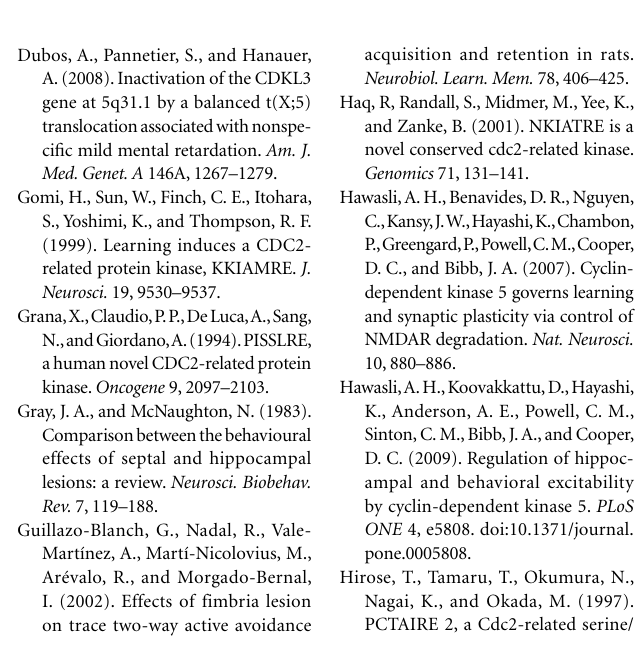
no signifi cant interaction between genotype and day ( F P = 0.9680). (B) AR latency by trial days. Unpaired Student’s t- test revealed no signifi cant differences between Cdkl2 + / + and Cdkl2 LacZ/LacZ mice. = 1.176, P = 0.2881) and (1, 26)